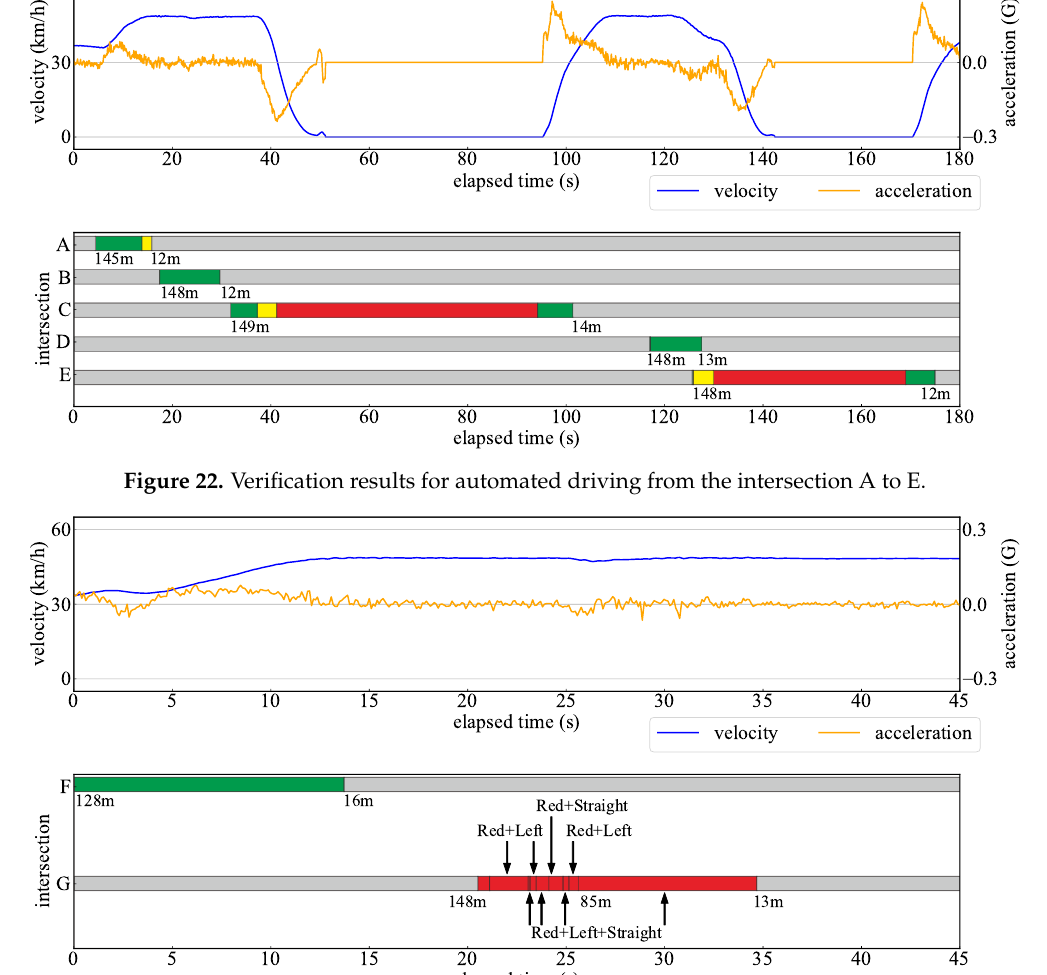
Figure 23. Verification results for automated driving from the intersection F to